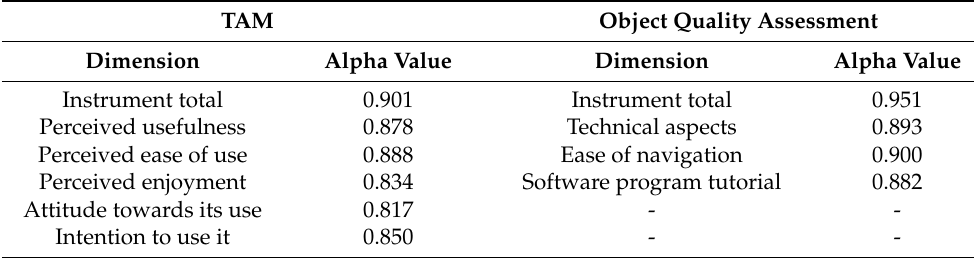
Table 2. Cronbach’s alpha of the respective questionnaires and sections used. TAM